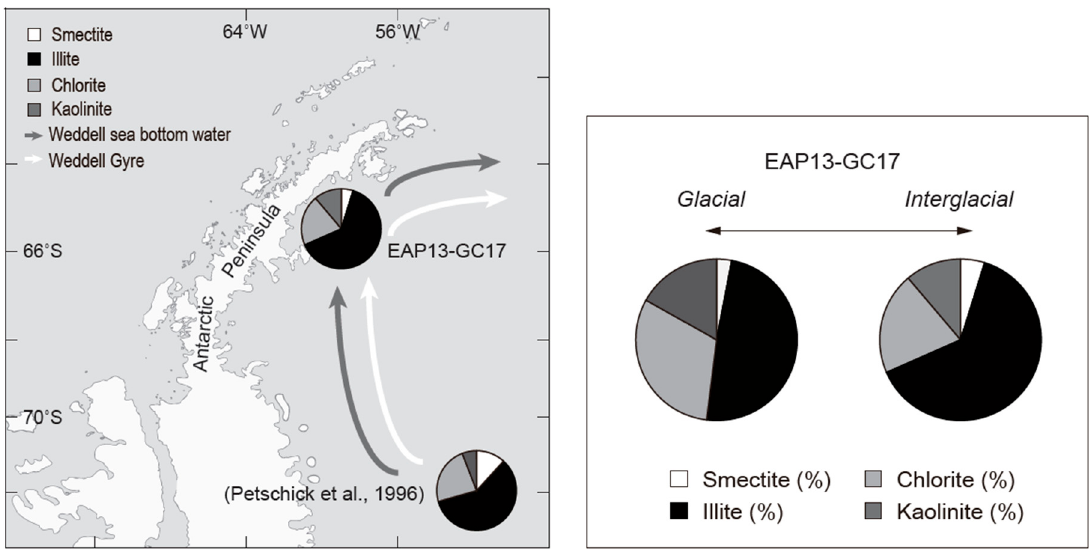
Figure 5. Average clay mineral composition of sediments in the upper unit of the core. Deep and shallow water circulation paths are taken from the compilation of Hernández-Molina et al. (2006) [51]. Compositional variations in sediment core EAP13-GC17, as displayed by clay mineralogical wheel diagrams. Two different relative proportions of clay minerals are related to glacial and interglacial periods.